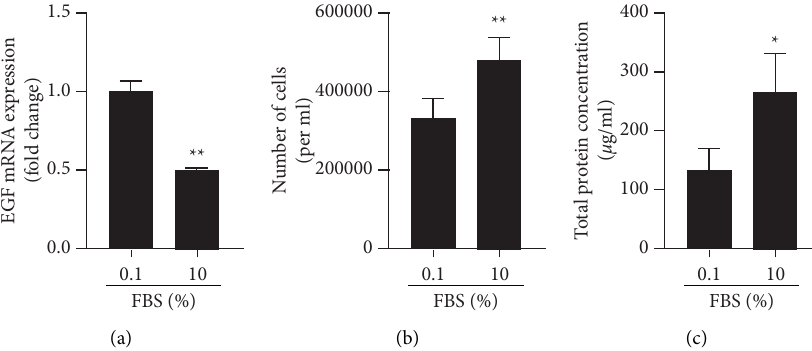
Figure 6: EGF gene expression is lower in growth-stimulated than in growth-restricted HaCaT cells. (a–c) Cells were incubated in the FBS-free culture medium for 8 h to standardize the experimental conditions and then stimulated with either low (0.1%) or high (10%) concentration of FBS for 24 h representing growth-restricted and growth-stimulated conditions, respectively. EGF mRNA levels were determined by qPCR using the delta-delta Ct method (a). Cells were stained with trypan blue, and the number of cells was counted using an automatic cell counter (b). Total protein concentration in cell lysates was investigated using a Bio-Rad DC protein assay kit (c). Experiments were performed three times in duplicate or triplicate. Values are presented as means ± SEM for three experiments in each group. Statistical signifcance was calculated using Student’s two-tailed t test for single comparison between the two groups (0.1 vs . 10% FBS) as appropriate. ∗ represents P < 0 . 05, and ∗∗ represents P < 0 . 01.